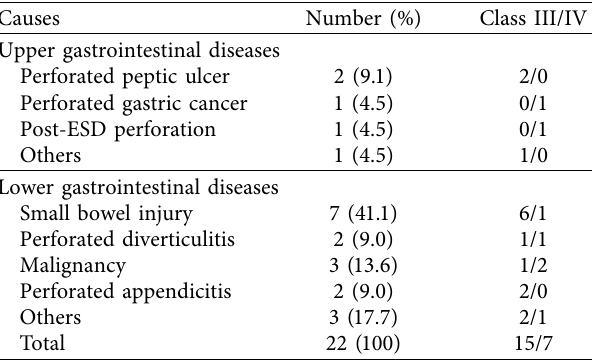
Table 2: Causes of intraabdominal contamination and CDC wound classifcation.